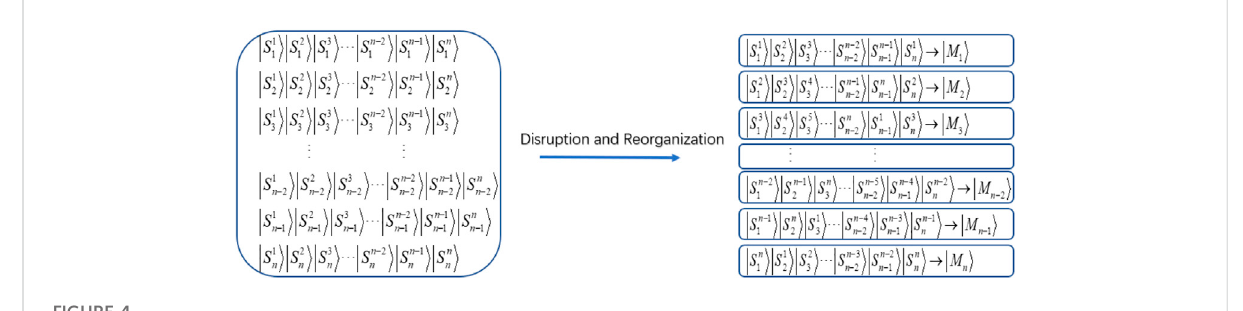
FIGURE 4 Generation process of the | M 〉